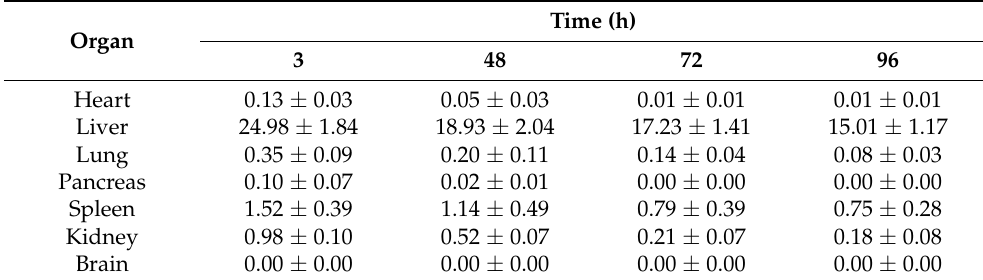
Table 2. Biodistribution (% injected dose) of 177 Lu 2 O 3 -iFAP in CD1 mice at various time points (mean ± SD) ( n = 3) after intravenous